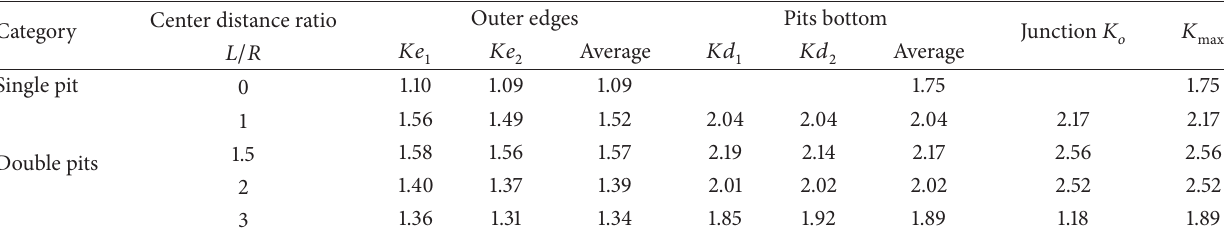
Table 2: Double pits stress concentration factor of steel